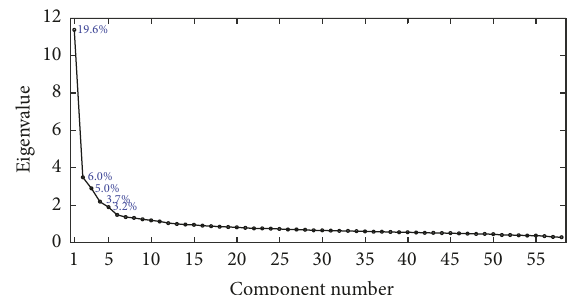
Figure2:Eigenvaluesofthecorrelationmatrixsortedindescending order (“scree plot”). Also shown are the percentages of variance explained (being proportional to the eigenvalue) for the first five components. It can be seen that one dominant component emerged, explaining 19.6% of the